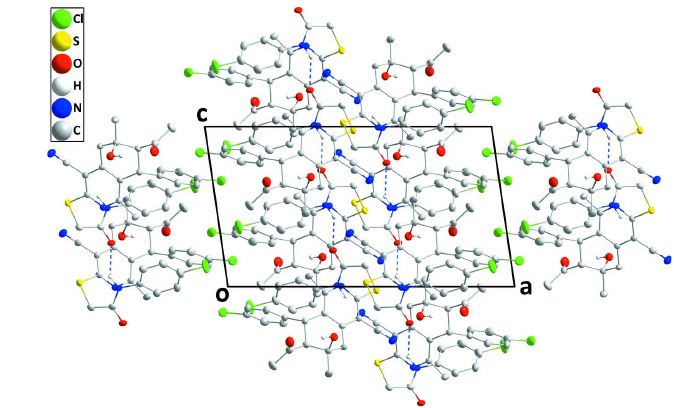
Figure 3 Packing viewed along the b -axis direction with N—H (cid:2)(cid:2)(cid:2) O hydrogen bonds depicted by dashed lines.